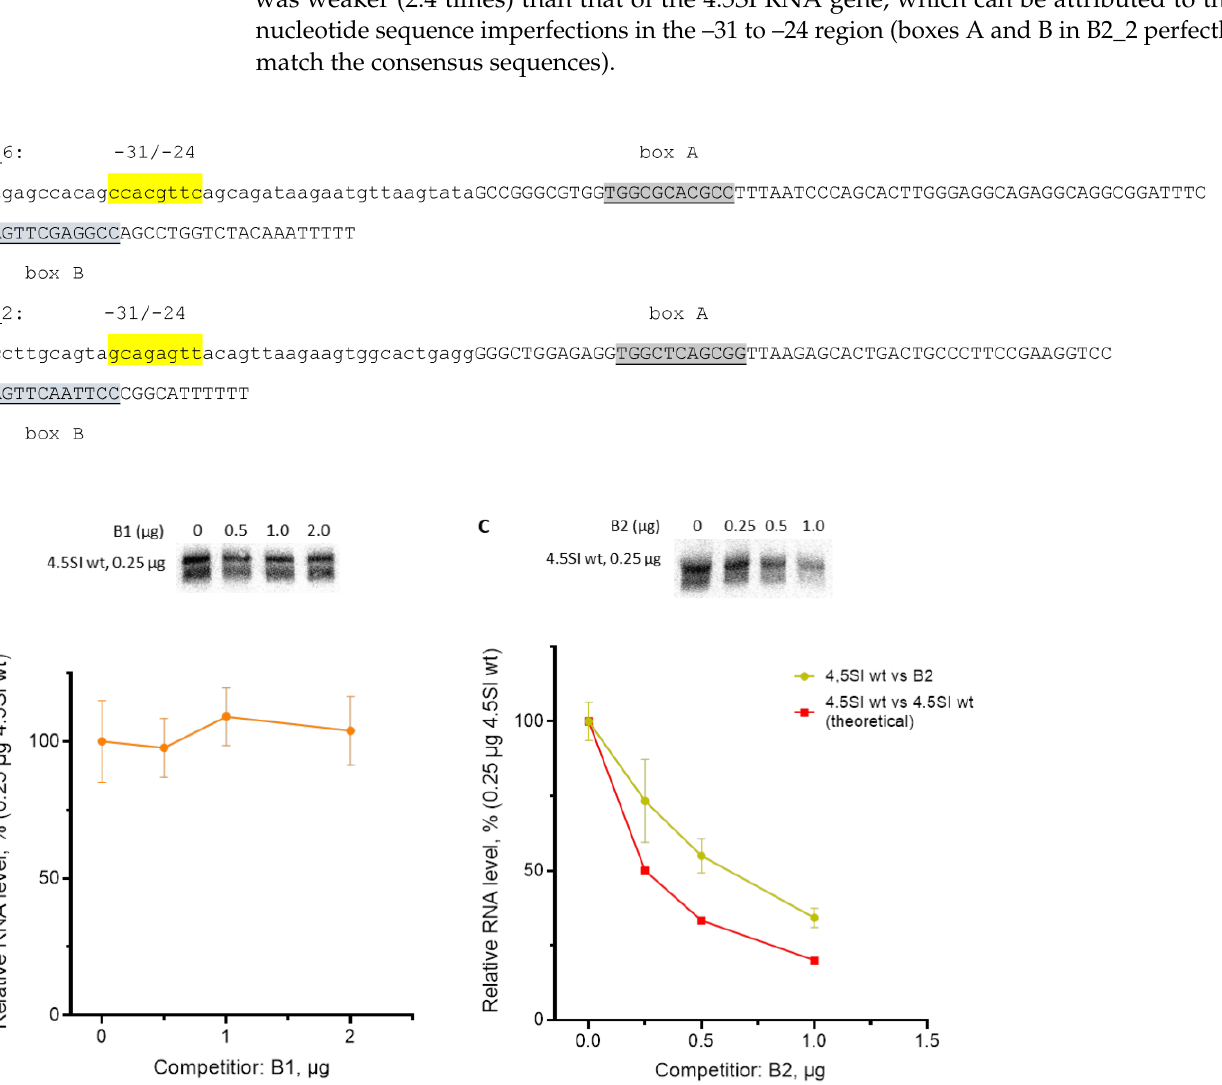
Figure 7. Transcriptional competition of 4.5SI gene with B1 and B2 SINEs in transfected HeLa cells. ( A ) Nucleotide sequences of the constructs containing mouse B1_6 and B2_2 copies. SINEs were truncated downstream of boxes B, and a transcription terminator T 5–6 was added to the end. The SINE and 5′ - flanking nucleotide sequences are shown in uppercase and lowercase, respectively. The nucleotides at positions −31/−24 are highlighted in yellow. Boxes A and B are underlined and highlighted in grey. ( B ) Transcription of 4.5SIwt with different amounts of the B1_6 construct (competitor). ( C ) Transcription of 4.5SIwt with different amounts of the B2_2 construct (competitor). The plots below summarize Northern hybridization data. The red line in ( C ) shows competition of 4.5SIwt with a hypothetical gene with a promotor of the same strength as that of the 4.5SI RNA gene promotor. Error bars, SD, n = 3 (see original Northern blot images for three replicates in Figure S4).